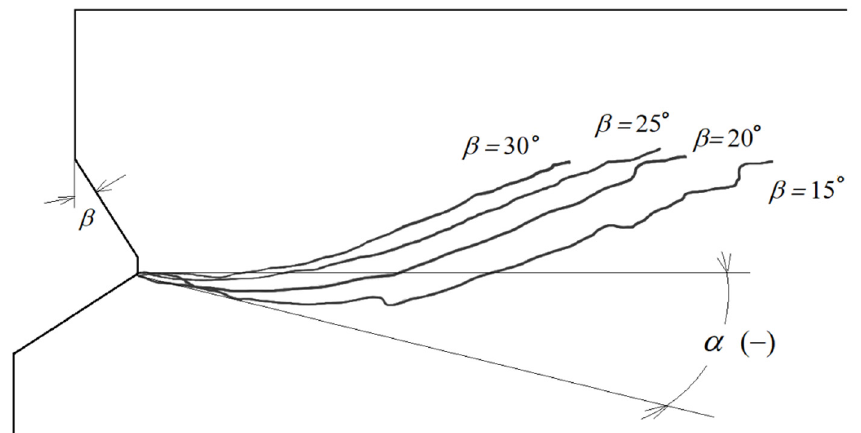
Figure 10. A comparison of sandstone fracture trajectories under anchor action at different stages of wear (summary) for equal anchor depths h ef = 50 mm, (for β = 15 ◦ highest head wear–smallest undercutting head cone due to abrasive wear, β = 30 ◦ —the angle of the new head), and α —initial penetration angle of the failure surface.